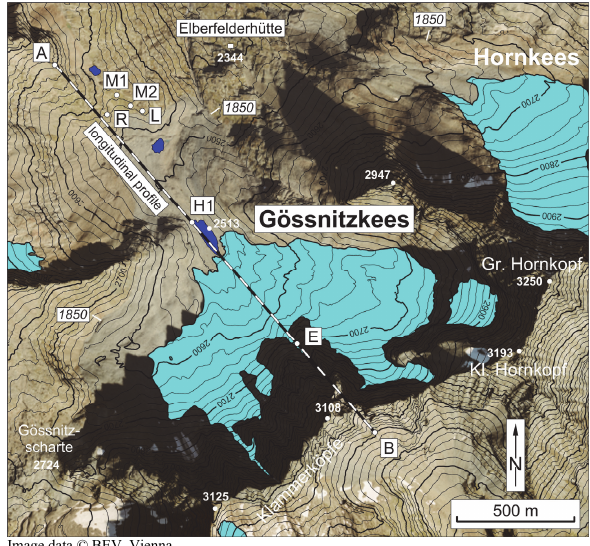
Figure 2. Local map (situation of